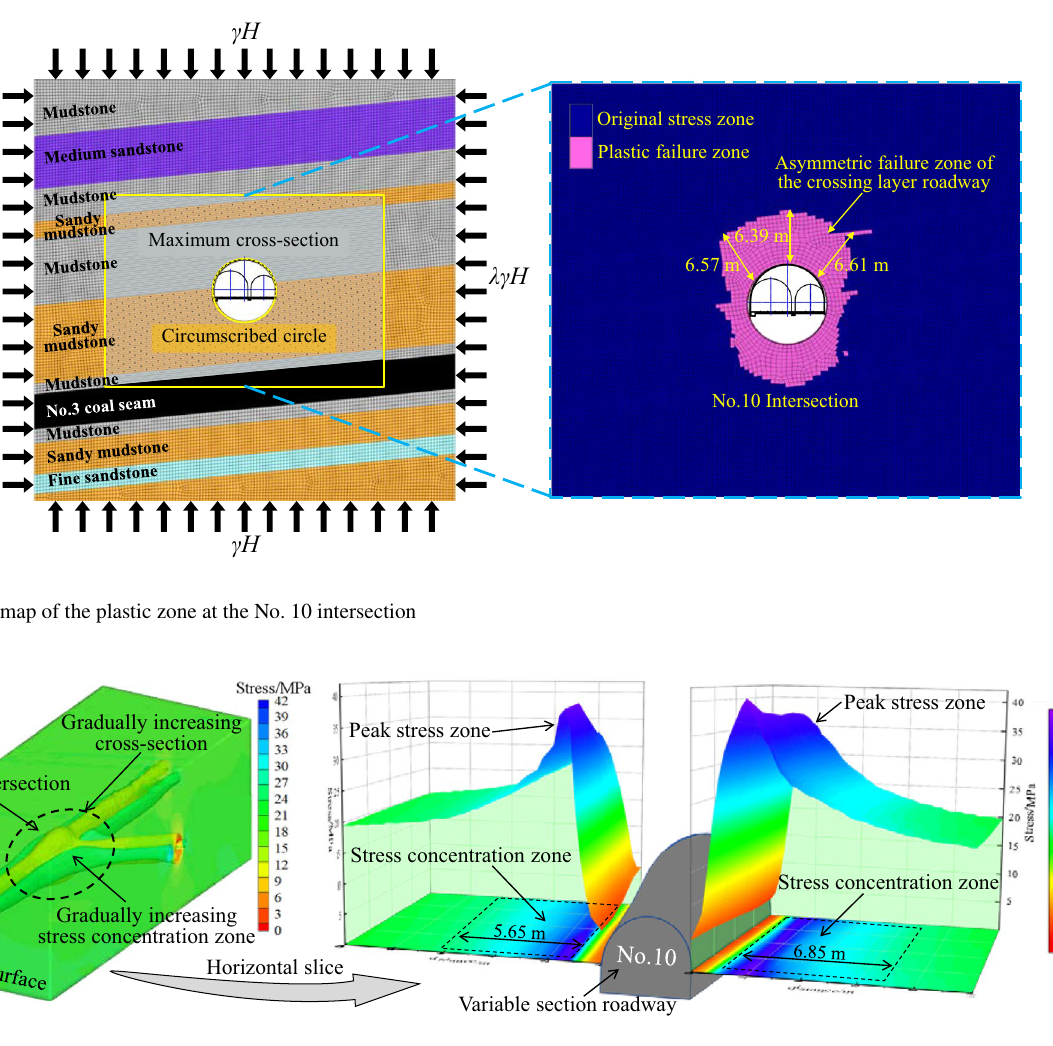
Fig. 16 Cloud map of the stress at the No. 10